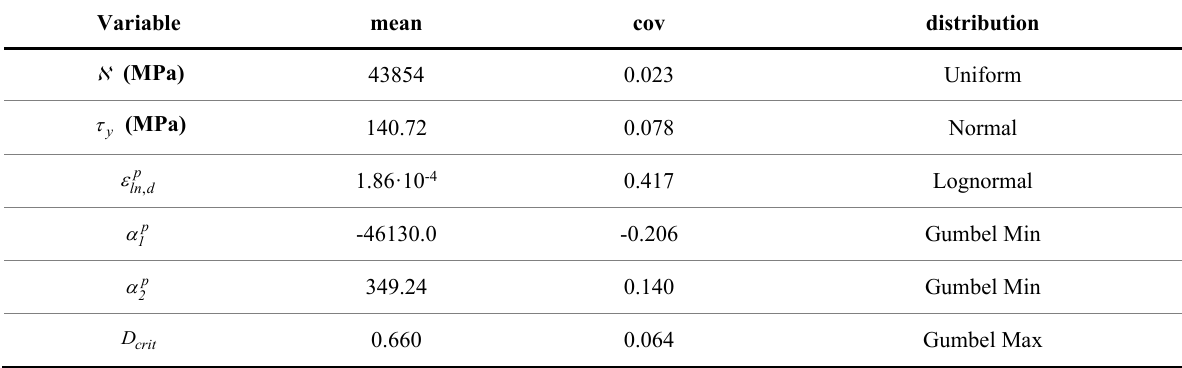
Table 4. Statistics for FLHB model: UHPFRC in